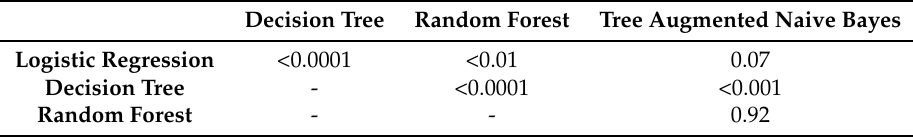
Table 6. Pairwise comparison of the test ROC curves (Delong’s paired test).